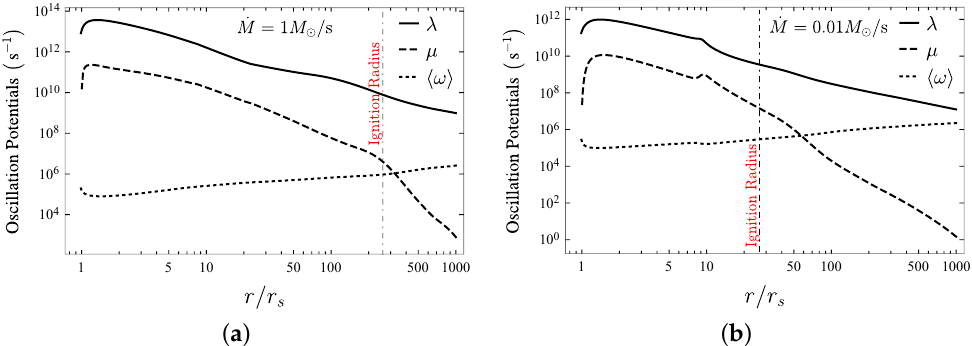
Figure 5. Oscillation potentials as functions of r with M = 3 M (cid:12) , α = 0.01, a = 0.95 for accretion rates ( a ) ˙ M = 1 M (cid:12) s − 1 and ( b ) ˙ M = 0.01 M (cid:12) s − 1 , respectively. The vertical line represents the position of the ignition